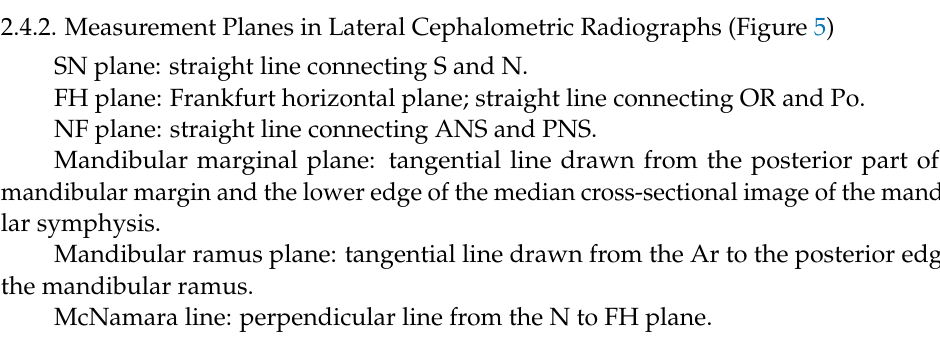
Figure 5. Measurement sites in lateral cephalometric